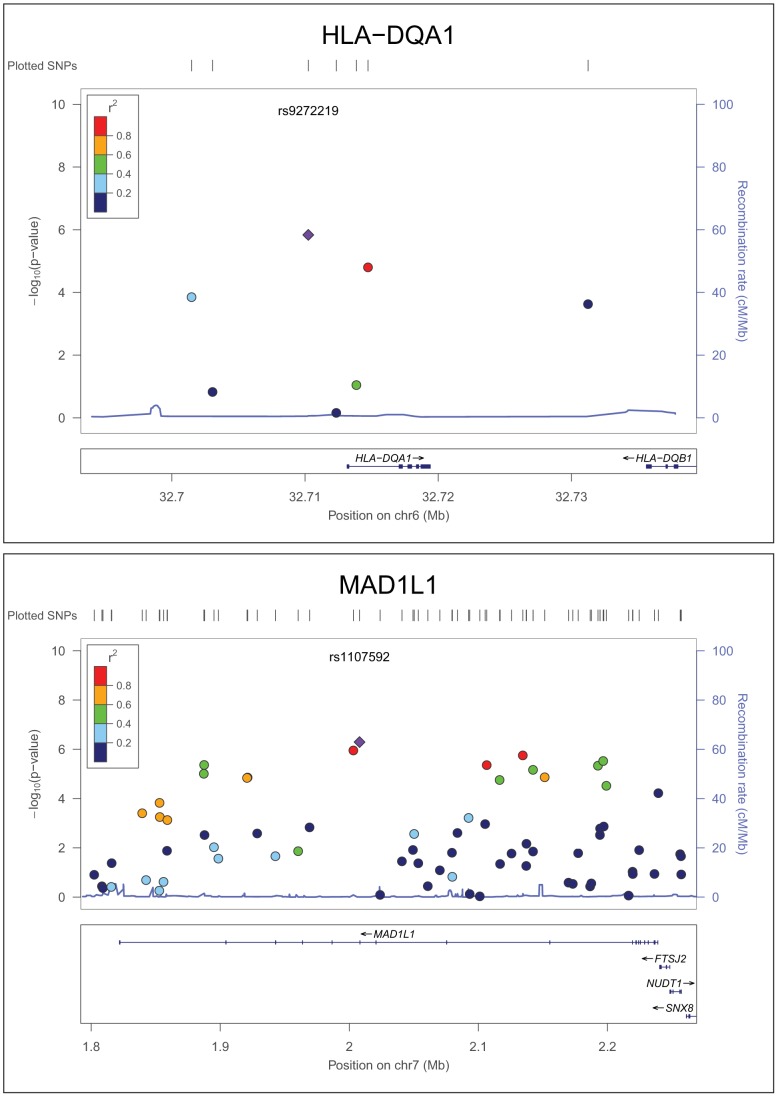
Meta-analysis results of the two most significant genes.Figures were generated using the LocusZoom online tool. X-axis is the genome coordinate. Y-axis is the -logP
meta values. Each point represents a SNP. The color of points is according to their level of linkage disequilibrium (LD) with the index SNPs. In this case, the index SNP is the most significant one in each panel. The LD measure is r2 based on the HapMap CEU population (release 22).